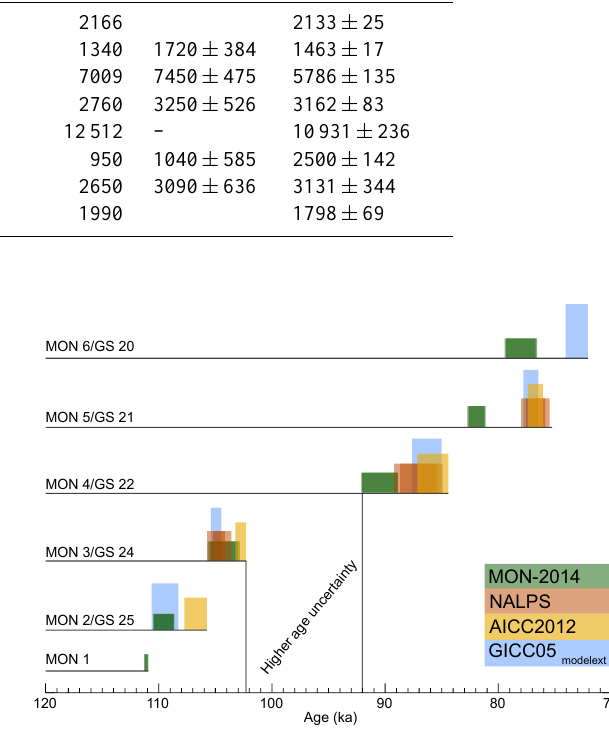
Figure 8. Comparison of the timing and duration of the stadials GS 25 to GS 20 and MON 1 to MON 6 in the North Atlantic and Eu- ropean region as displayed by the different independent chronolo- gies: GICC05 modelext , AICC2012, NALPS and MON-2014.